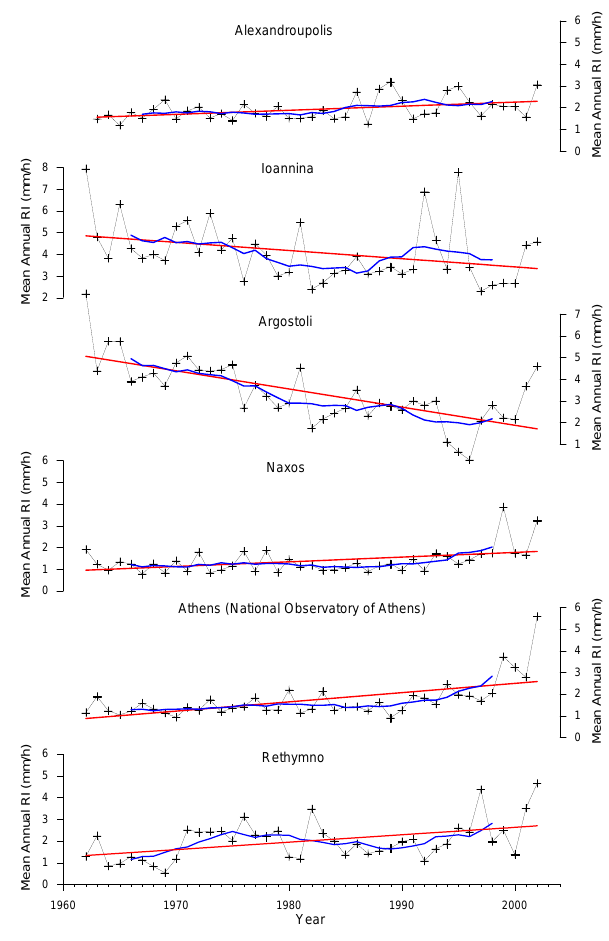
Figure 4 . Time series of the mean annual RI (mm/h), along with 9-year points moving average (blue line) and trend (red line), for selected stations in Greece, during the period 1962-2002.